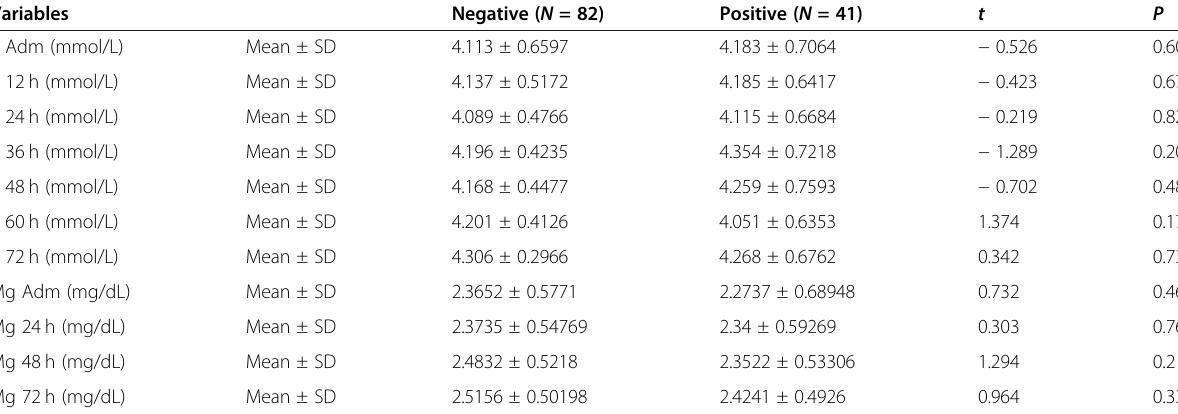
Table 2 Comparison of serum potassium and magnesium levels between patients with postoperative atrial fibrillation and those without Variables Negative ( N = 82) Positive ( N = 41) t P K Adm (mmol/L) Mean ± SD